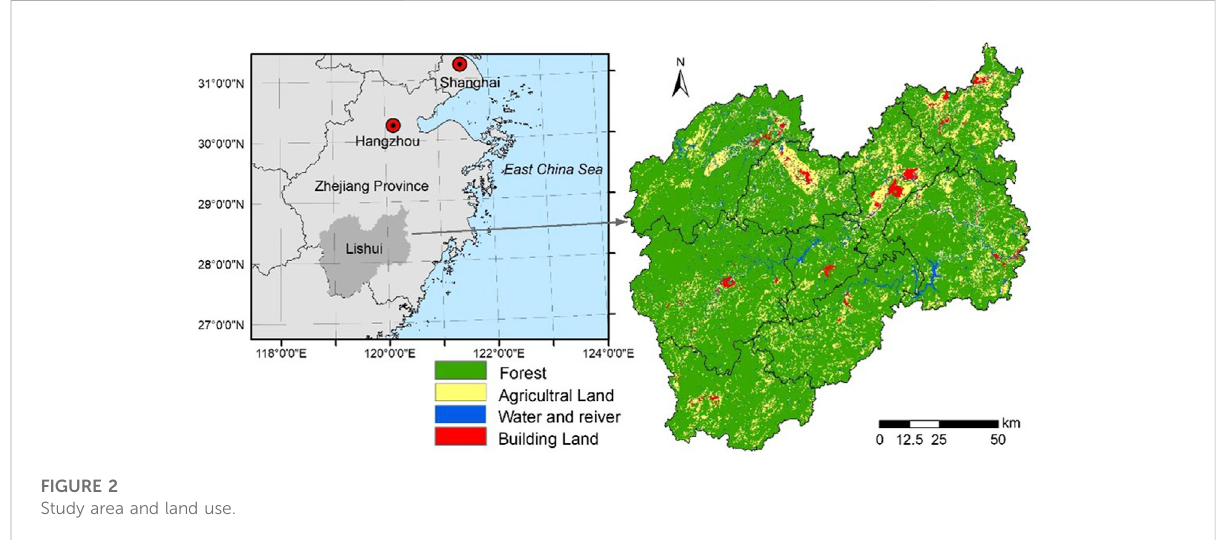
FIGURE 2 Study area and land